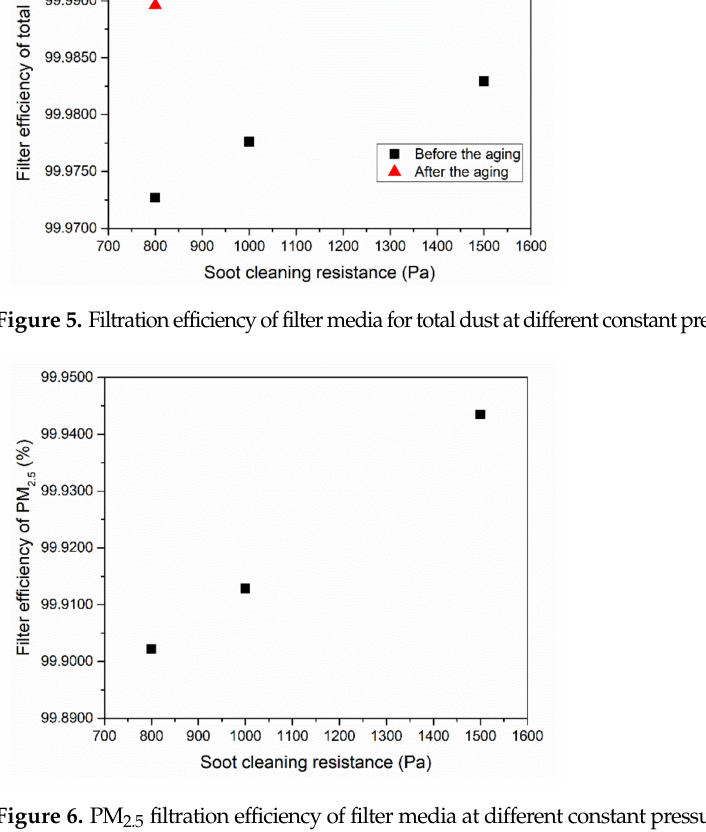
Figure 6. PM 2.5 filtration efficiency of filter media at different constant pressure soot cleaning